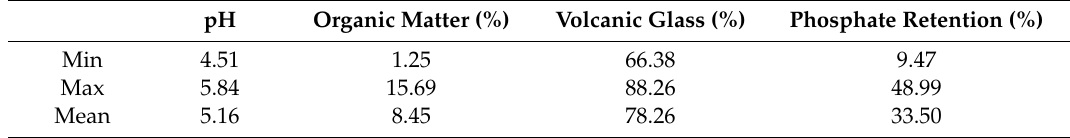
Table 1. Properties of volcanic soil